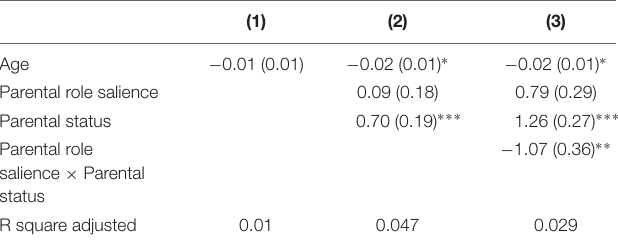
TABLE 2 | The influence of parental role salience and parental status on intertemporal